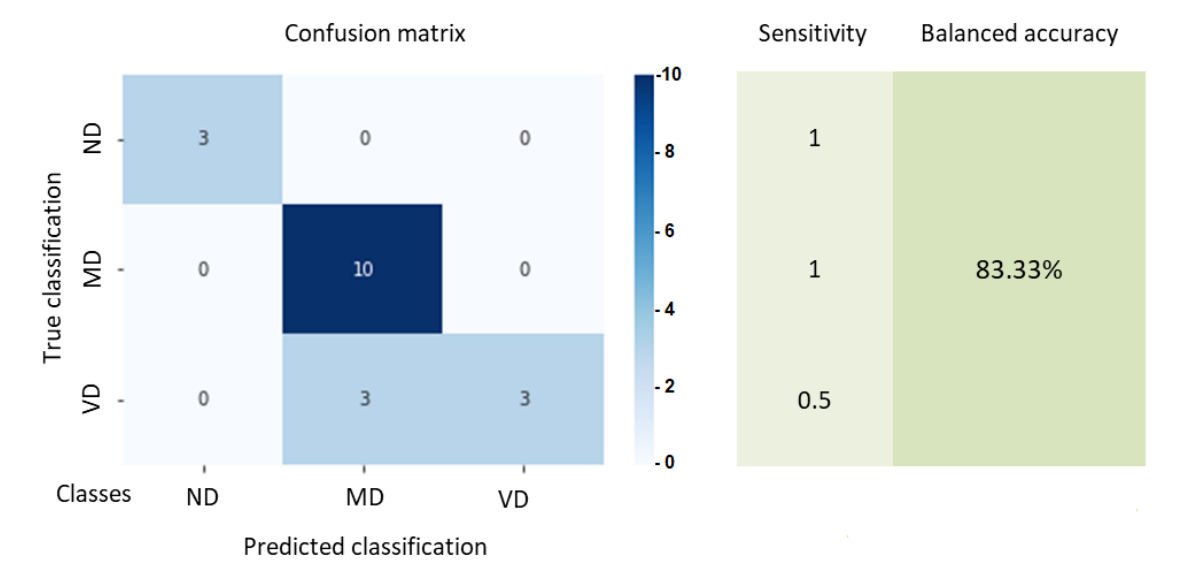
Figure 14. Confusion matrix, sensitivity and balanced